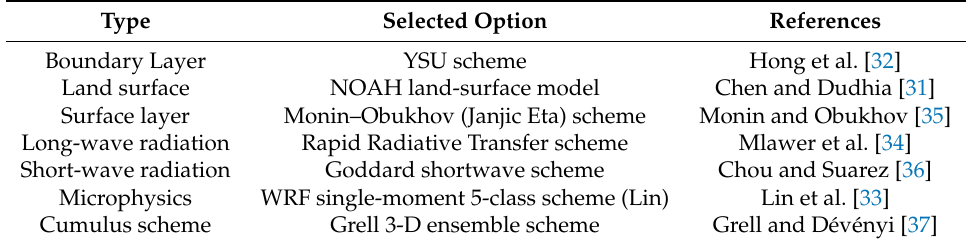
Table 1. Physics schemes used in WRF model set-up for Greater